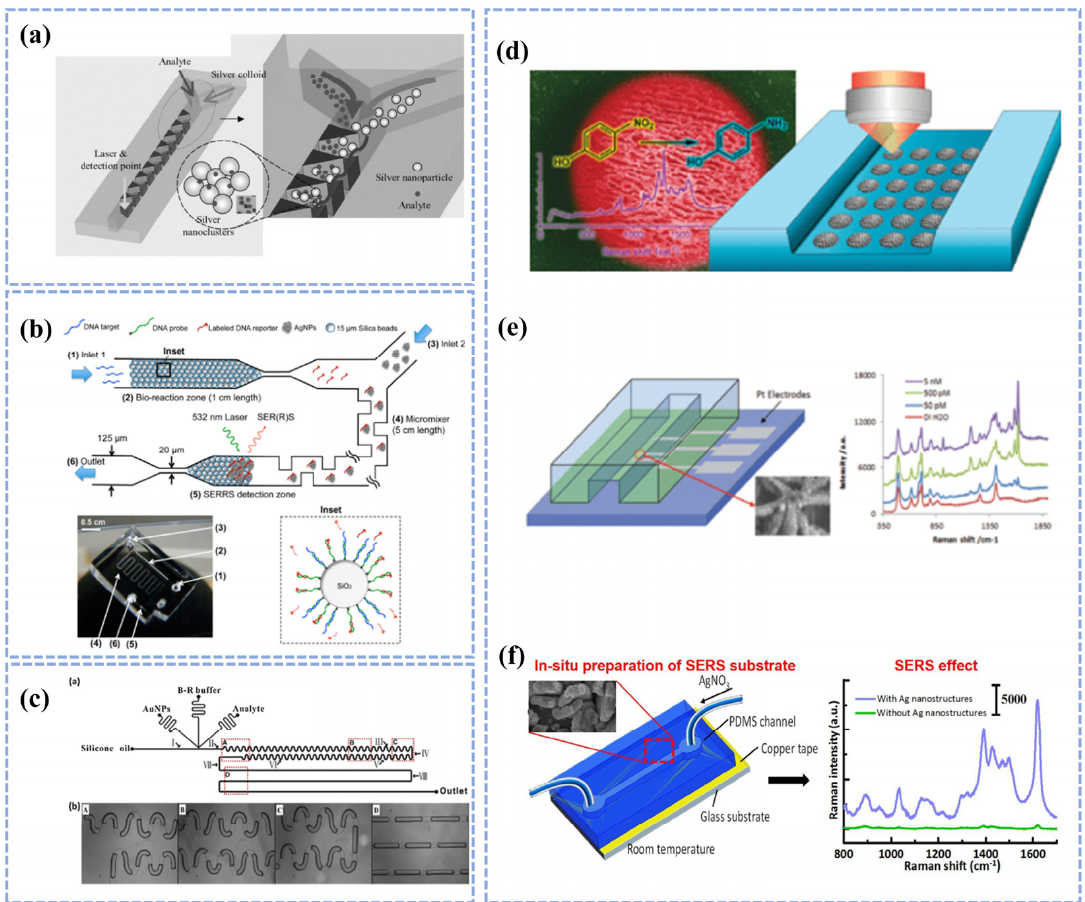
Figure 5. Integration of SERS-active substrates into the microfluidic system. ( a ) A zigzag microfluidic channel was used to mix analytes and colloidal nanoparticles and for SERS detection. ( b ) The special microchannel structure filled with silica particles enables the aggregation of nanoparticles within the detection volume and a significant increase in the SERS signal of analyte molecules (adapted with permission from [108]. Copyright {2013} American Chemical Society). ( c ) The application of droplet microfluidics avoids the direct contact between the sample and the channel wall, reduces the memory effect, and achieves more efficient mixing between the sample and colloidal nanoparticles. ( d ) Femtosecond laser processing fabricated 50 silver microflora arrays composed of nanoparticles within microchannels to serve as SERS substrates. ( e ) Fabrication of a novel Ag NP-decorated nanowall structure within a microfluidic channel for use as a SERS substrate (adapted with permission from [103]. Copyright {2013} American Chemical Society). ( f ) Synthesis of Ag nanostructures in a microfluidic channel via a chemical-electrical displacement reaction between Ag and